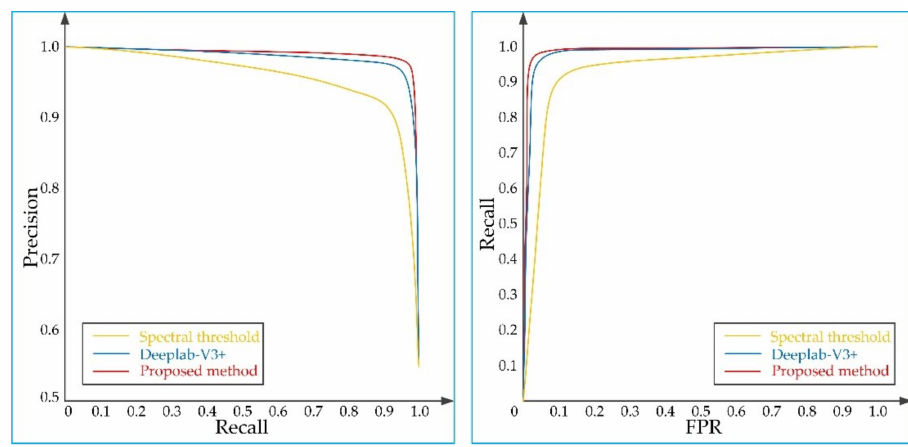
Figure 11. Comparison curves of different methods. ( a ) PR curve; ( b ) ROC